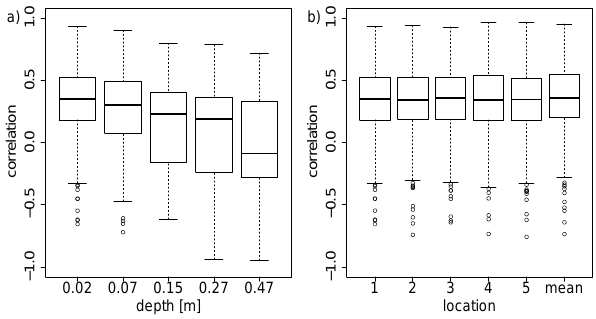
Fig. 7. Correlations between temperature and nighttime NEE at the Finish station Hyyti¨al¨a, based on temperature measurements in 5 depths (a) and the top measurement (0.02m) at 5 locations (b)